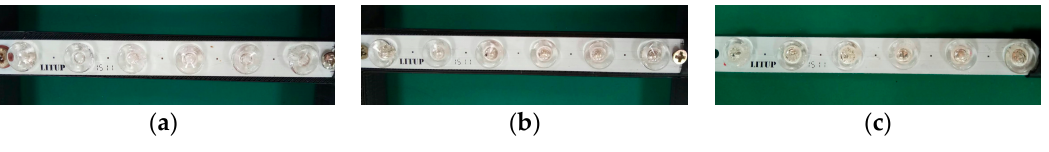
Figure 6. New mosquito trap UV_LED light bar module: ( a ) lighting of 130° angle, ( b ) lighting of 150° angle, ( c ) lighting of 170° angle.